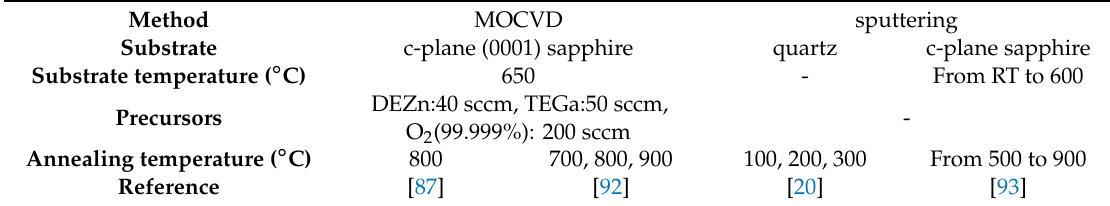
Table 7. Process parameters of the four references about photodetectors. ‘RT’ represents room temperature.